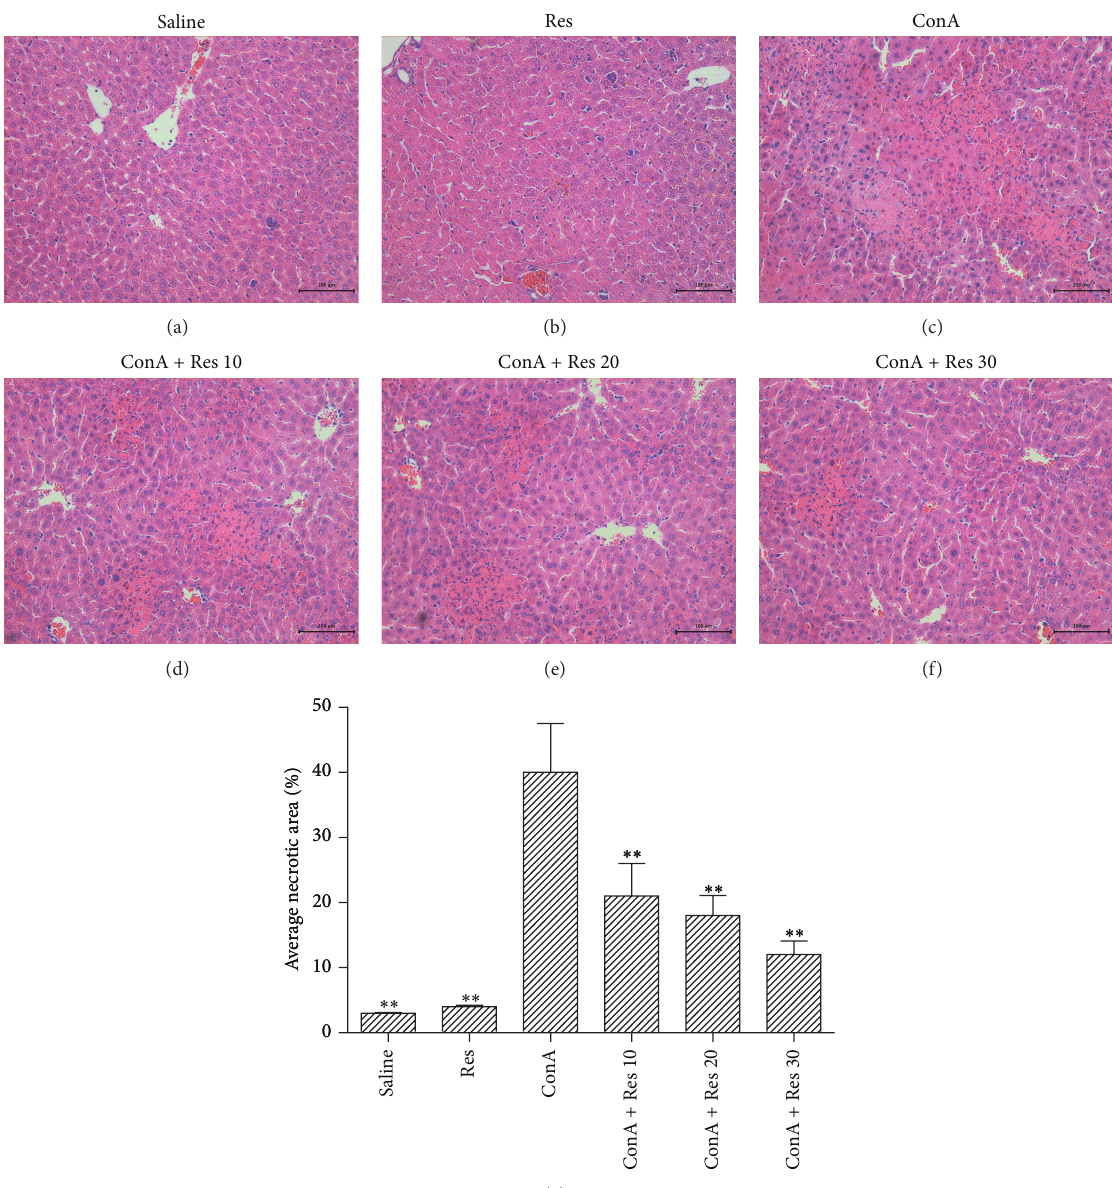
Figure 1: Resveratrol pretreatment attenuates ConA-induced autoimmune hepatitis. Liver histopathology in ConA-induced liver injury. Liver samples were taken from mice treated with ConA (20mg/kg) and mice treated with ConA and resveratrol (10, 20, and 30 mg/kg, resp., daily oral administration × 14 days). Sections were stained with H&E. (a) Saline group; (b) resveratrol-alone group; (c) ConA group: liver section from a mouse from the ConA-treated group showing extensive liver focal necrosis, portal infiltration, and interface hepatitis. H&E, magnification × 100; ((d)–(f)) ConA + Res (10mg/kg); ConA + Res (20mg/kg); ConA + Res (30 mg/kg): liver section from a mouse treated withConAandresveratrol,andliverhistologyshowsonlyaminimalgradeofcellularinfiltrationandhepatocytedamage.H&E,magnification × 100. (g) The necrotic areas were analyzed with Image-pro Plus 6.0, indicating statistical significance among groups.